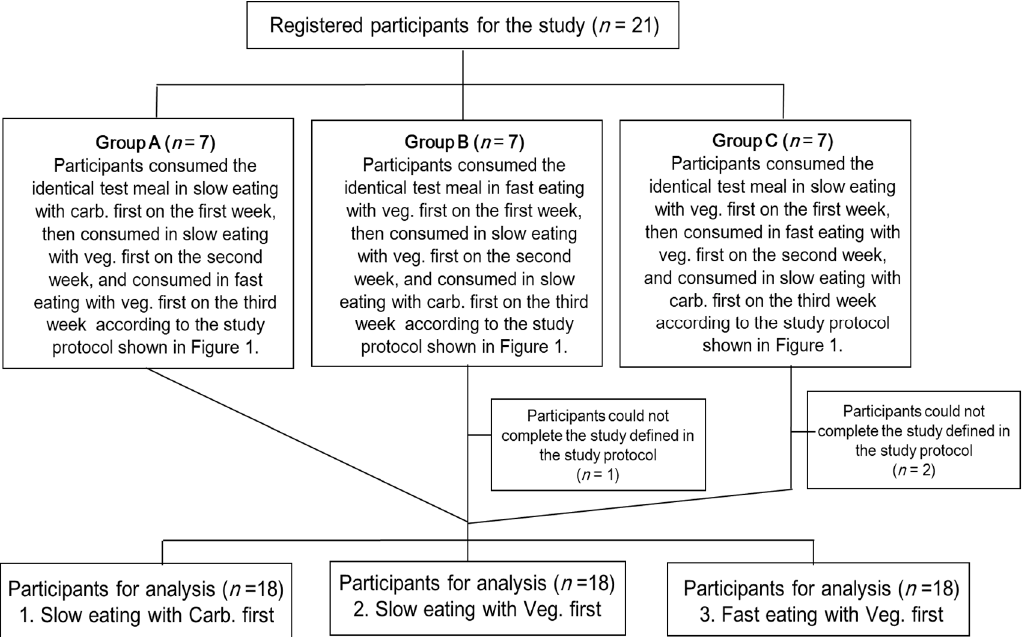
Figure 2. Study flow. Registered participants were divided into 3 groups with 7 participants